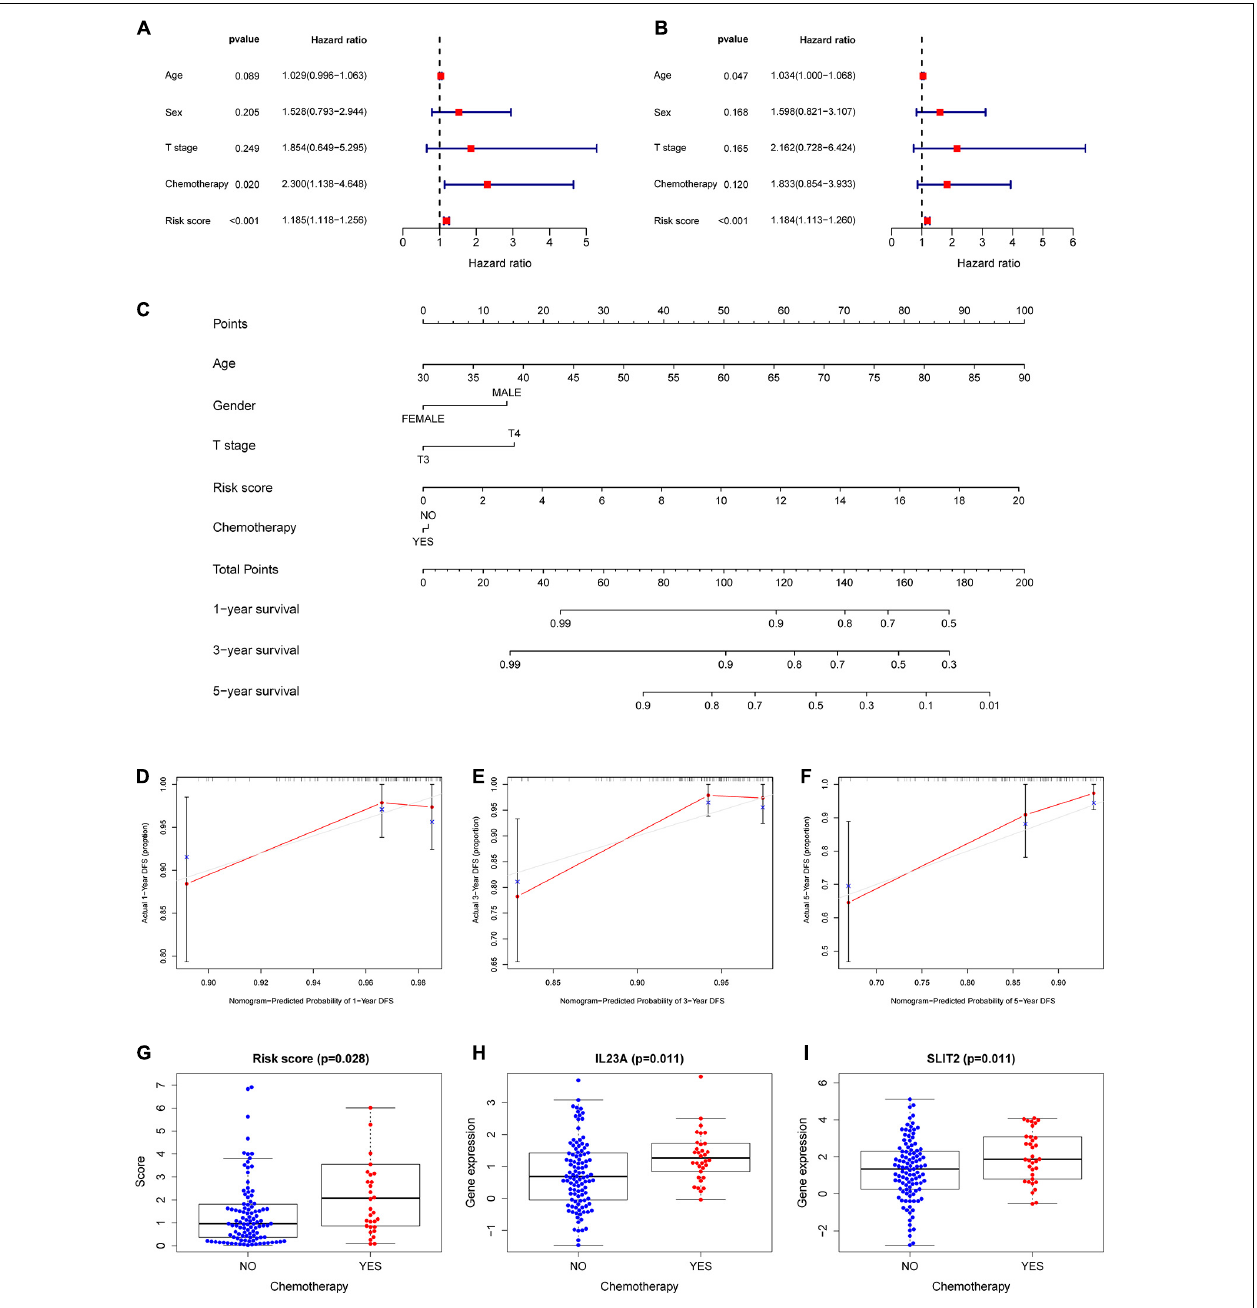
FIGURE 5 | Construction of a nomogram for survival assessment and association between the IRGCRCII model and clinicopathological characteristics. Univariate (A) and multivariate (B) Cox regression analyses for DFS of stage II CRC in the training cohort. Nomogram constructed by combining clinical characteristics and the IRGCRCII risk score (C) . The calibration plots for predicting 1- (D) , 3- (E) , and 5-years (F) DFS. The comparison of risk score (G) and expression levels of IL23A (H) and SLIT2 (I) between chemotherapy group and non-chemotherapy group. p < 0.05. CRC, colorectal cancer; DFS, disease-free survival.